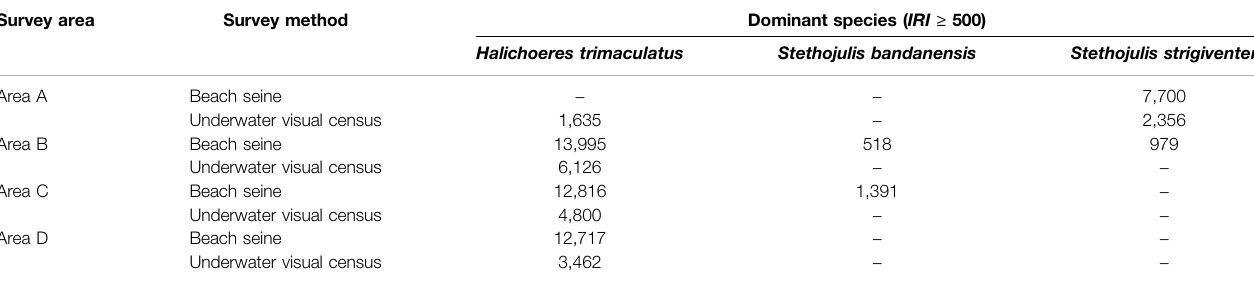
TABLE 1 | Dominant species determined by the index of relative importance ( IRI ) ≥